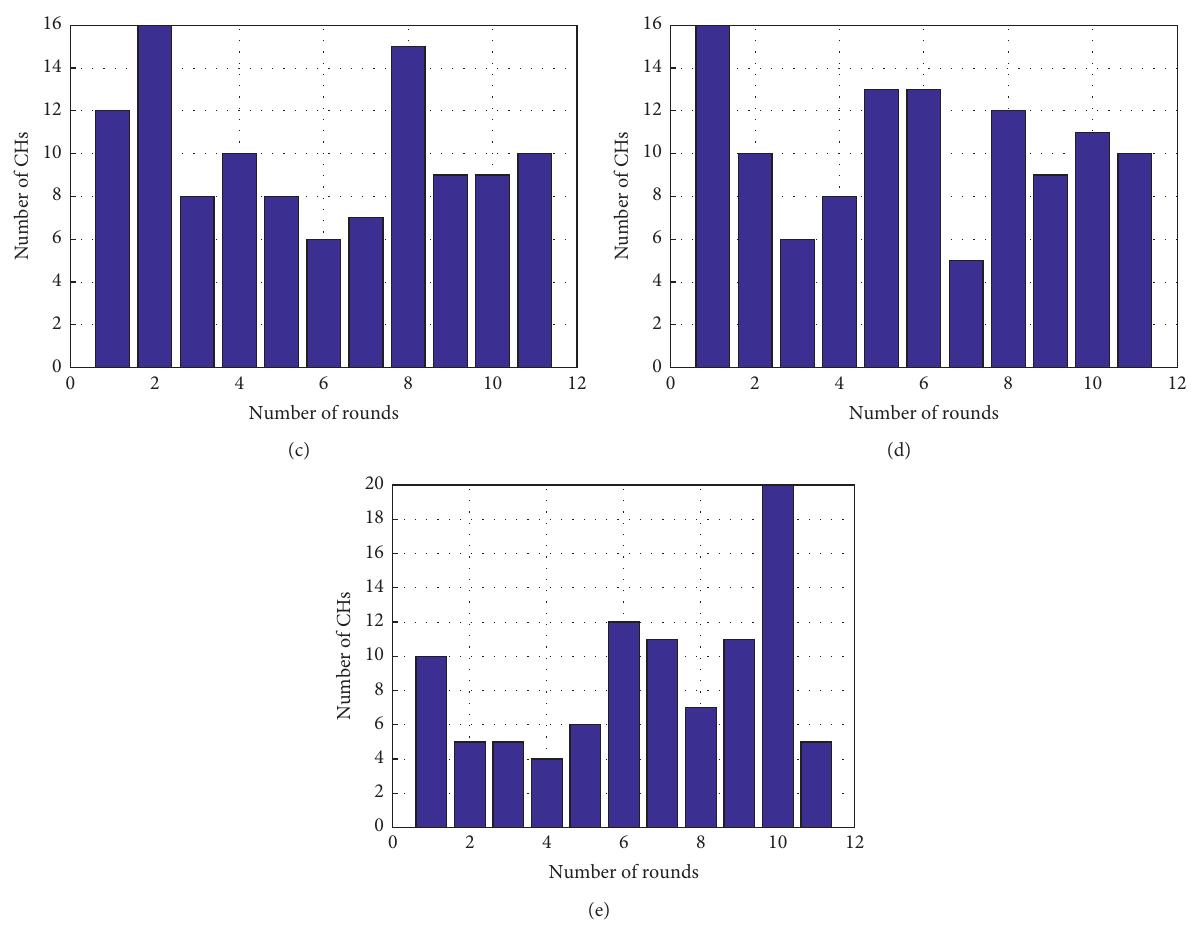
Figure 16: Statistics of CHs (a) in each zone of FOI-LEACH protocol, (b) of FOI-LEACH protocol, (c) of LEACH protocol, (d) of SEP protocol, and (e) of PECRP protocol with power supply.